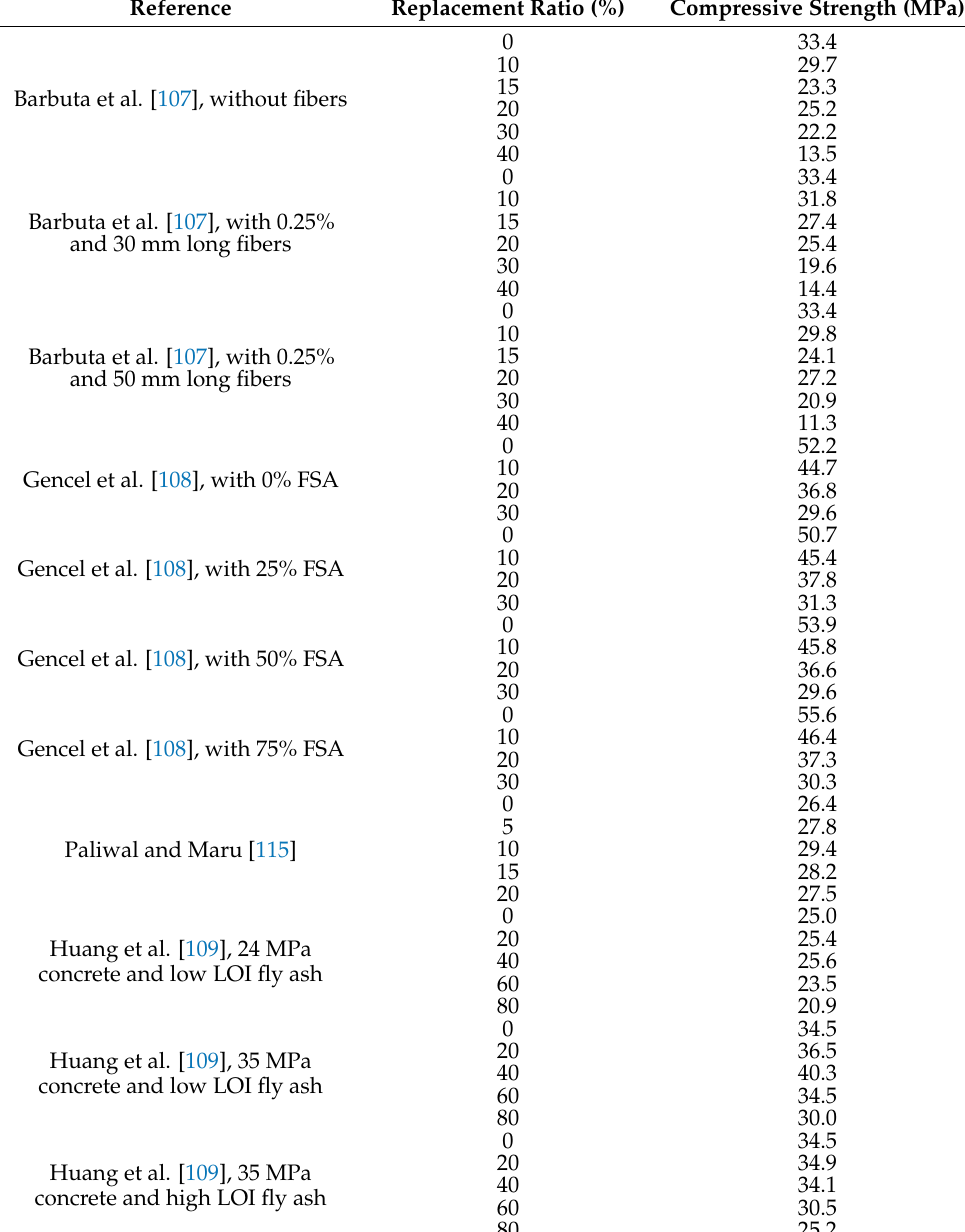
Table 2. Compressive strength (28-days) of composites containing fly ash.